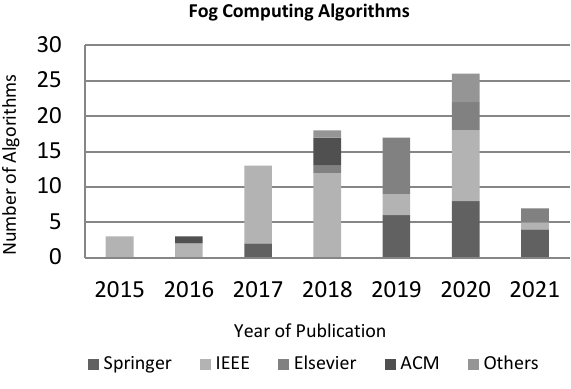
Fig. 1. Histogram of the papers considered for this study